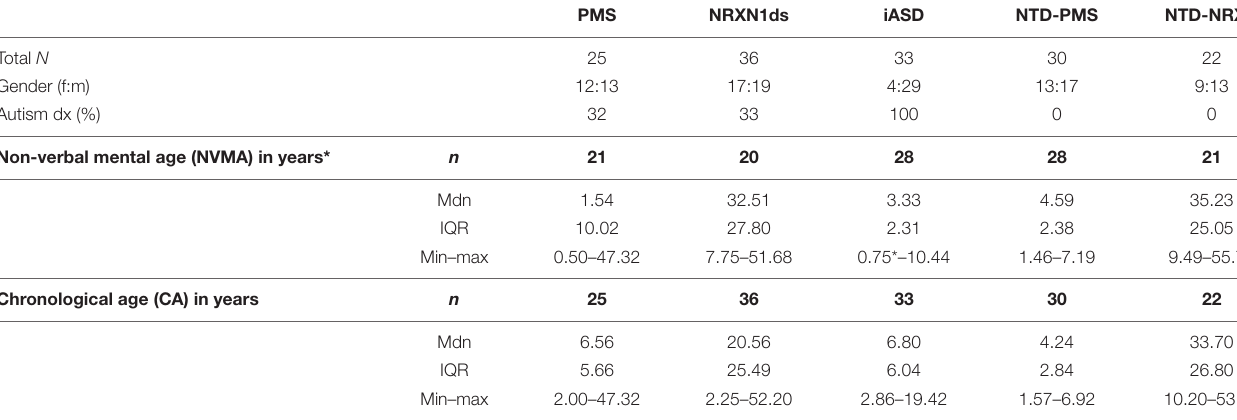
TABLE 1 | Current sample demographics including both KCL and TCD